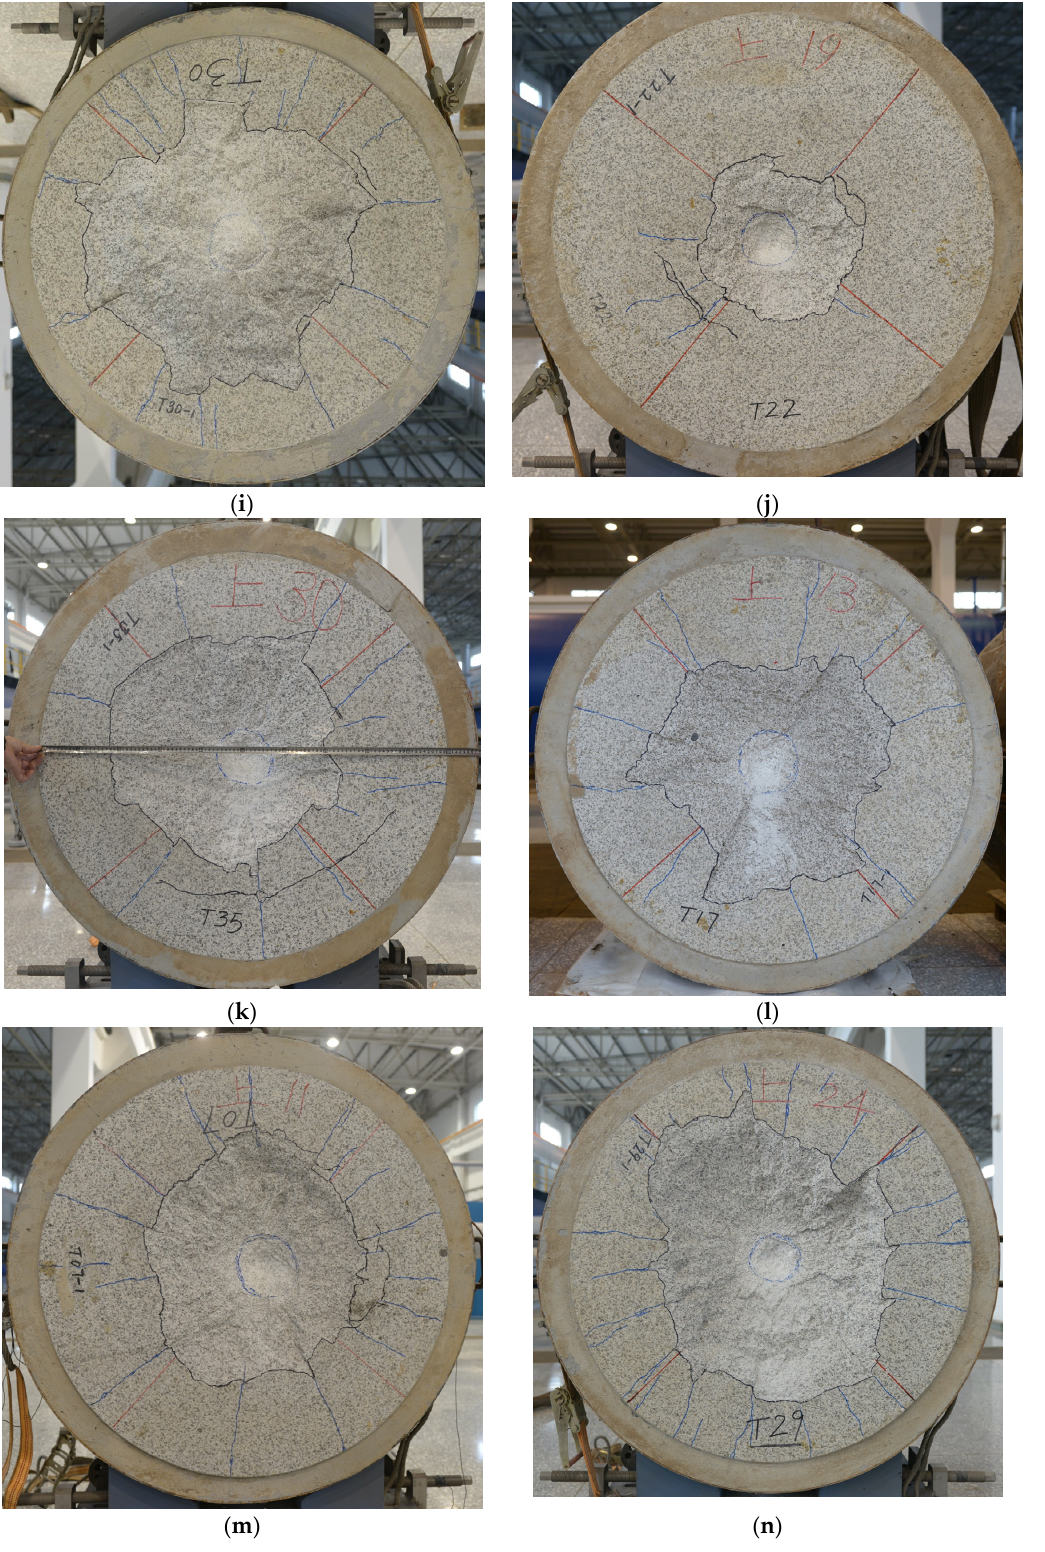
Figure 6. Experimental impact craters of the granite targets: ( a ) Shot No. 1; ( b ) Shot No. 2; ( c ) Shot No. 3; ( d ) Shot No. 4; ( e ) Shot No. 5; ( f ) Shot No. 6; ( g ) Shot No. 7; ( h ) Shot No. 8; ( i ) Shot No. 10; ( j ) Shot No. 11; ( k ) Shot No. 12; ( l ) Shot No. 13; ( m ) Shot No. 14; ( n ) Shot No. 15.